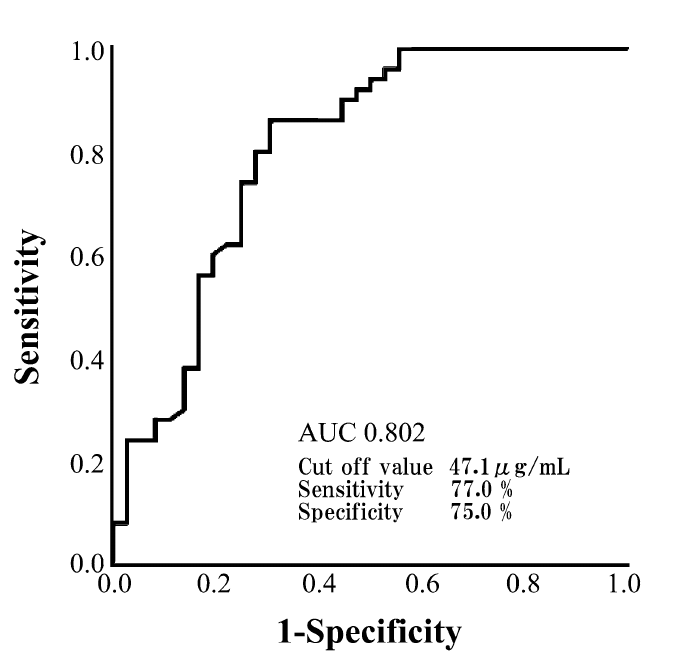
Figure 7. Receiver operating characteristic curve for HA for the differential diagnosis between BAPE and MPM. BAPE benign asbestos pleural effusion, MPM malignant pleural mesothelioma, HA hyaluronic acid (SPSS Statistics V26 for IBM Japan (https:// www. ibm. com/ jp- ja/ produ cts/ spss- stati